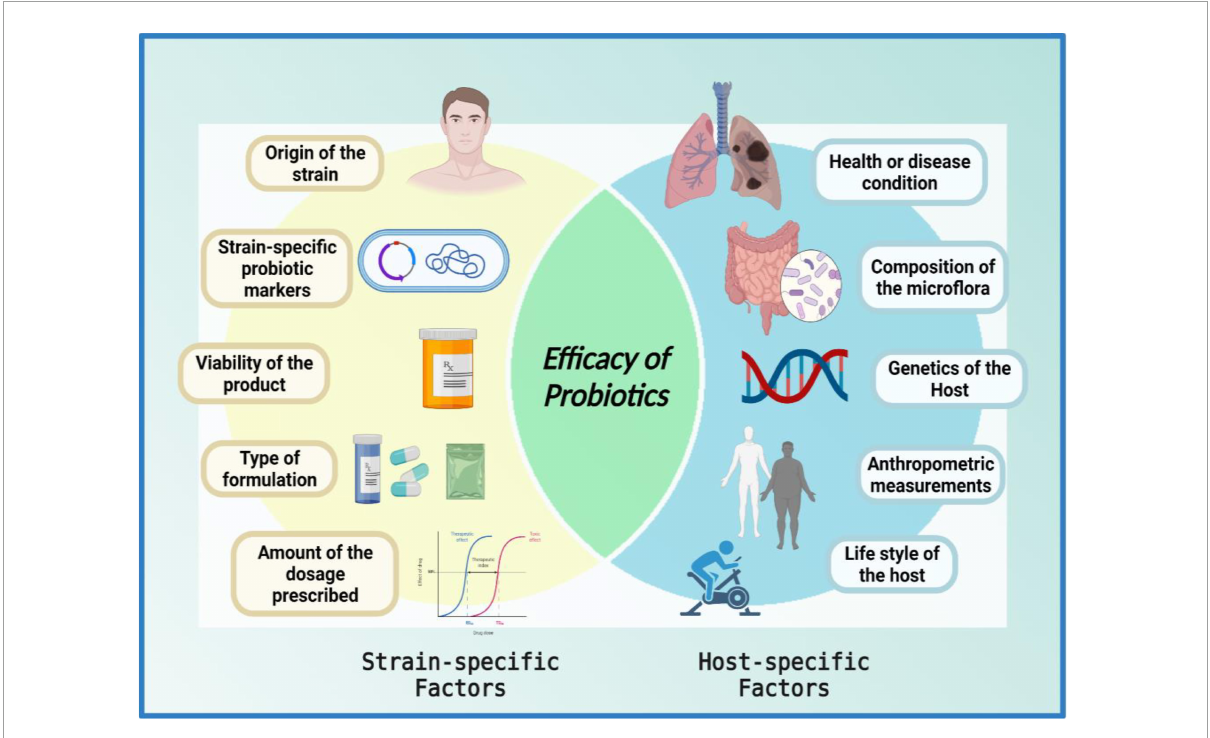
FIGURE3 Venn diagram of factors affecting the efficacy of probiotics. The efficacy of a probiotic is a result of the interplay between numerous strain-specific and host-specific factors. The figure was drawn with BioRender.